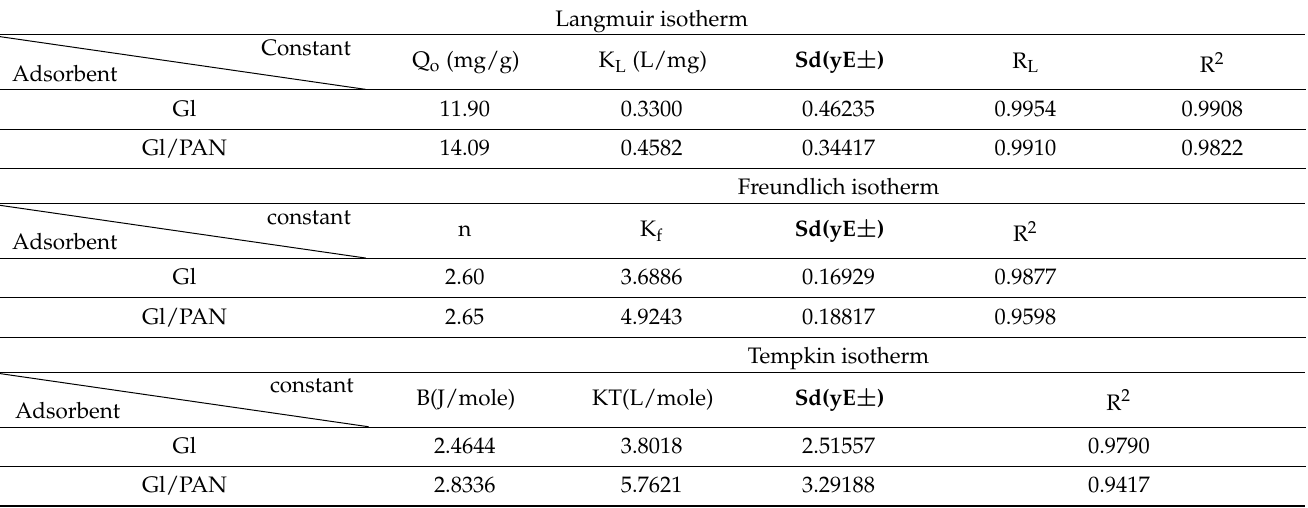
Figure 7. ( a , b ) Pseudo-first-order, ( c , d ) Pseudo-second-order, and ( e , f ) Elovich sorption kinetics of CR dye at 25 °C and pH 7 by 20 mg of ( a , c , e ) Gl and ( b , d , f ) Gl/PAN. The CR adsorption onto Gl and Gl/PAN adsorbents is well handled with the Pseudo- second-order diffusion model and this appears in the higher R 2 values from 5 ppm to 25